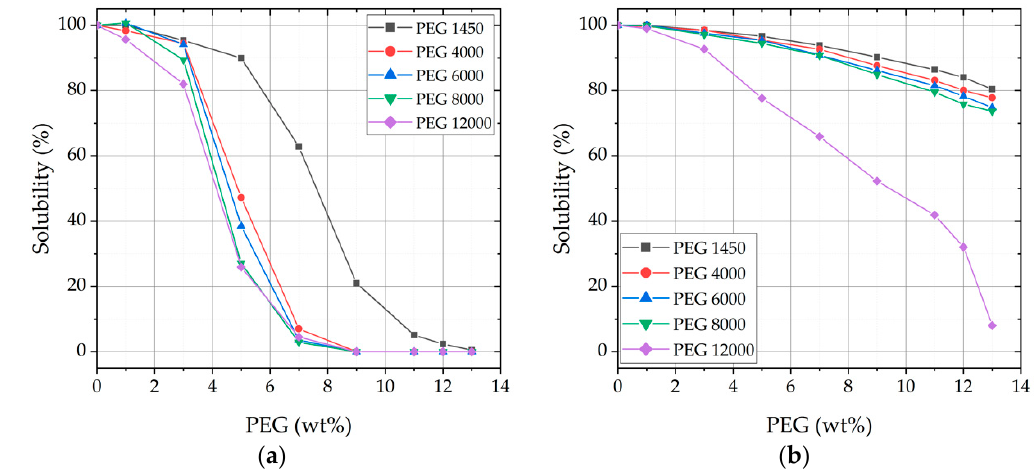
Figure 7. ( a ) Solubility curves of immunoglobulin (IgG) with different polyethylene glycols (PEGs) and varying PEG concentration respective to protein content. ( b ) Solubility curves of host cell proteins (HCPs) related to experiments shown in ( a ).